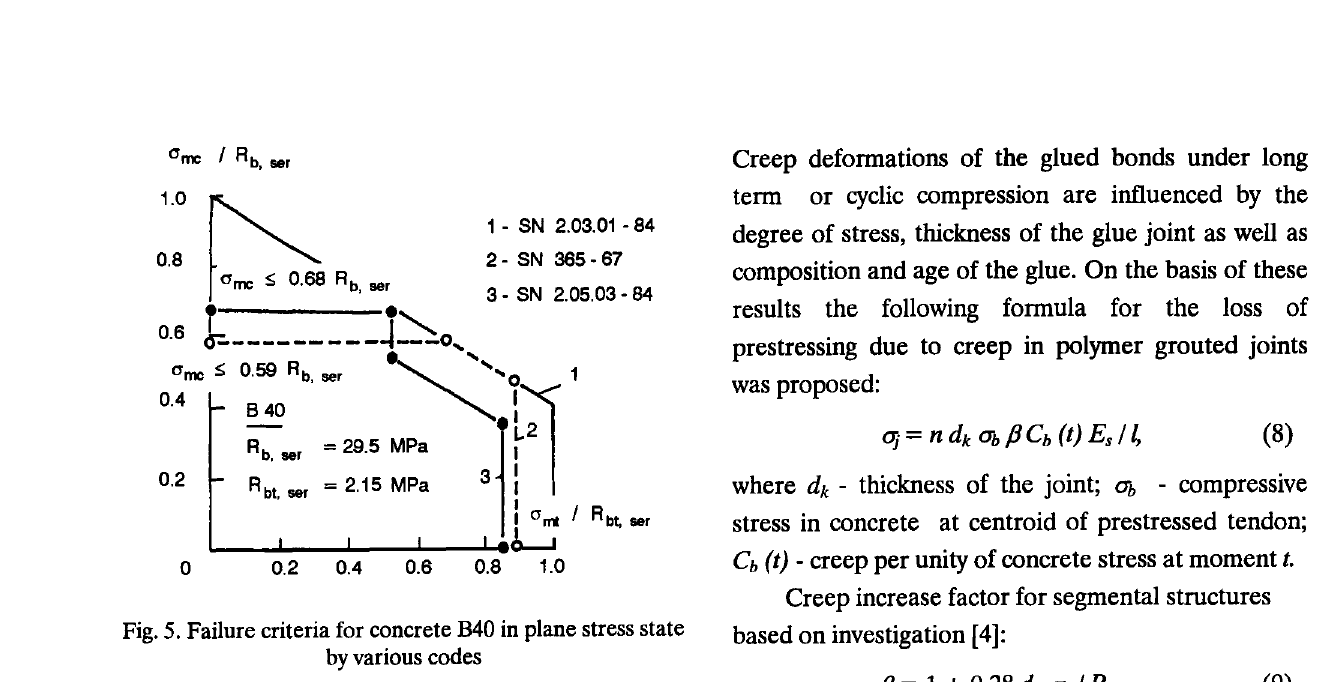
Fig. 5. Failure criteria for concrete B40 in plane stress state by various